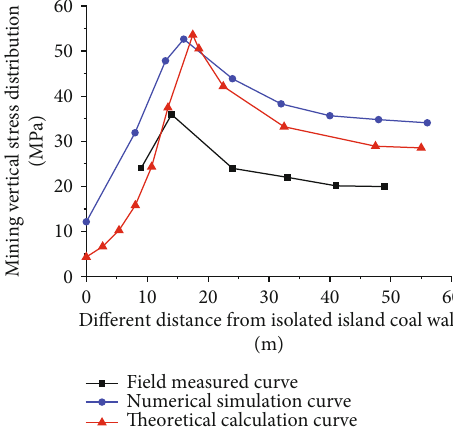
Figure 12: Contrast of the distribution of advance abutment pressure in the 61102 isolated island face in fully mechanized top- coal caving